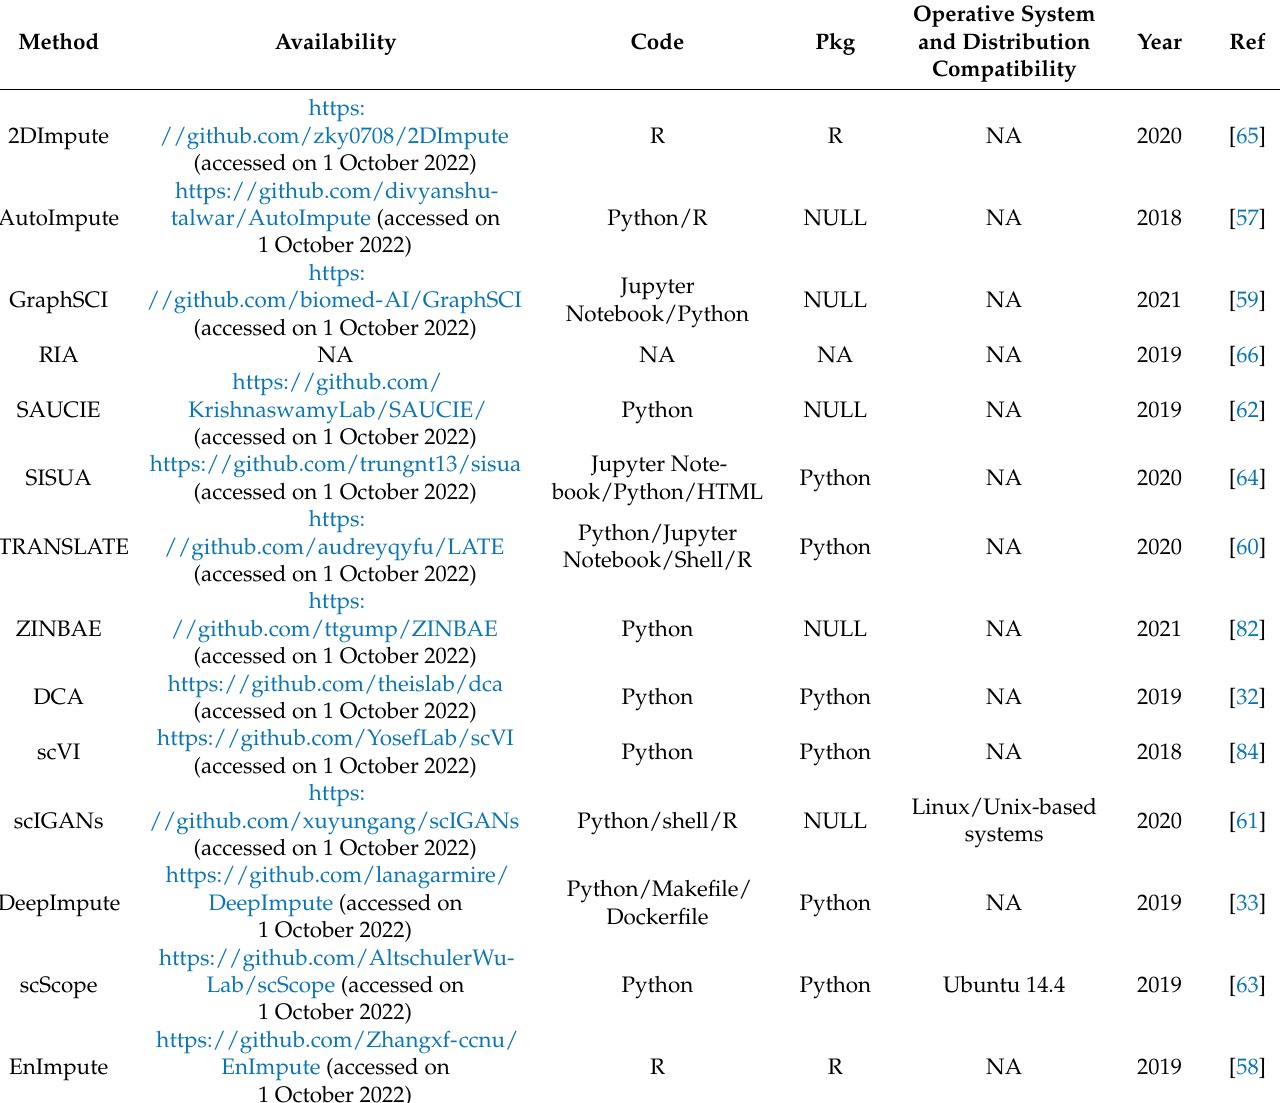
Table 5. The availability links, programming language, whether a package is available, year of presentation, operative system, distribution compatibility and reference of the representative methods based on deep